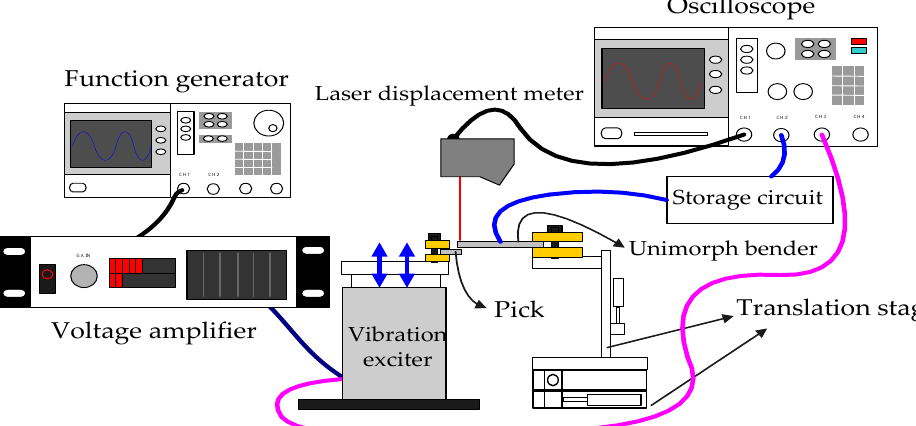
Figure 8. Experiment structure of cantilever harvester with free vibration to measure electric power generation and vibration situation.